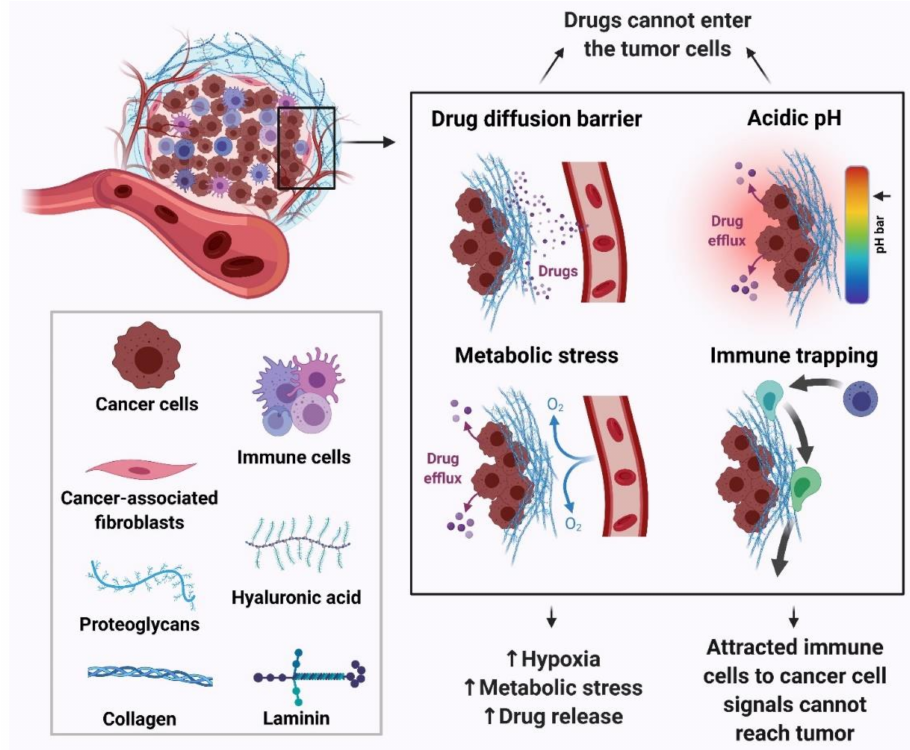
Figure 4. The effect of tumor microenvironment on chemoresistance in human